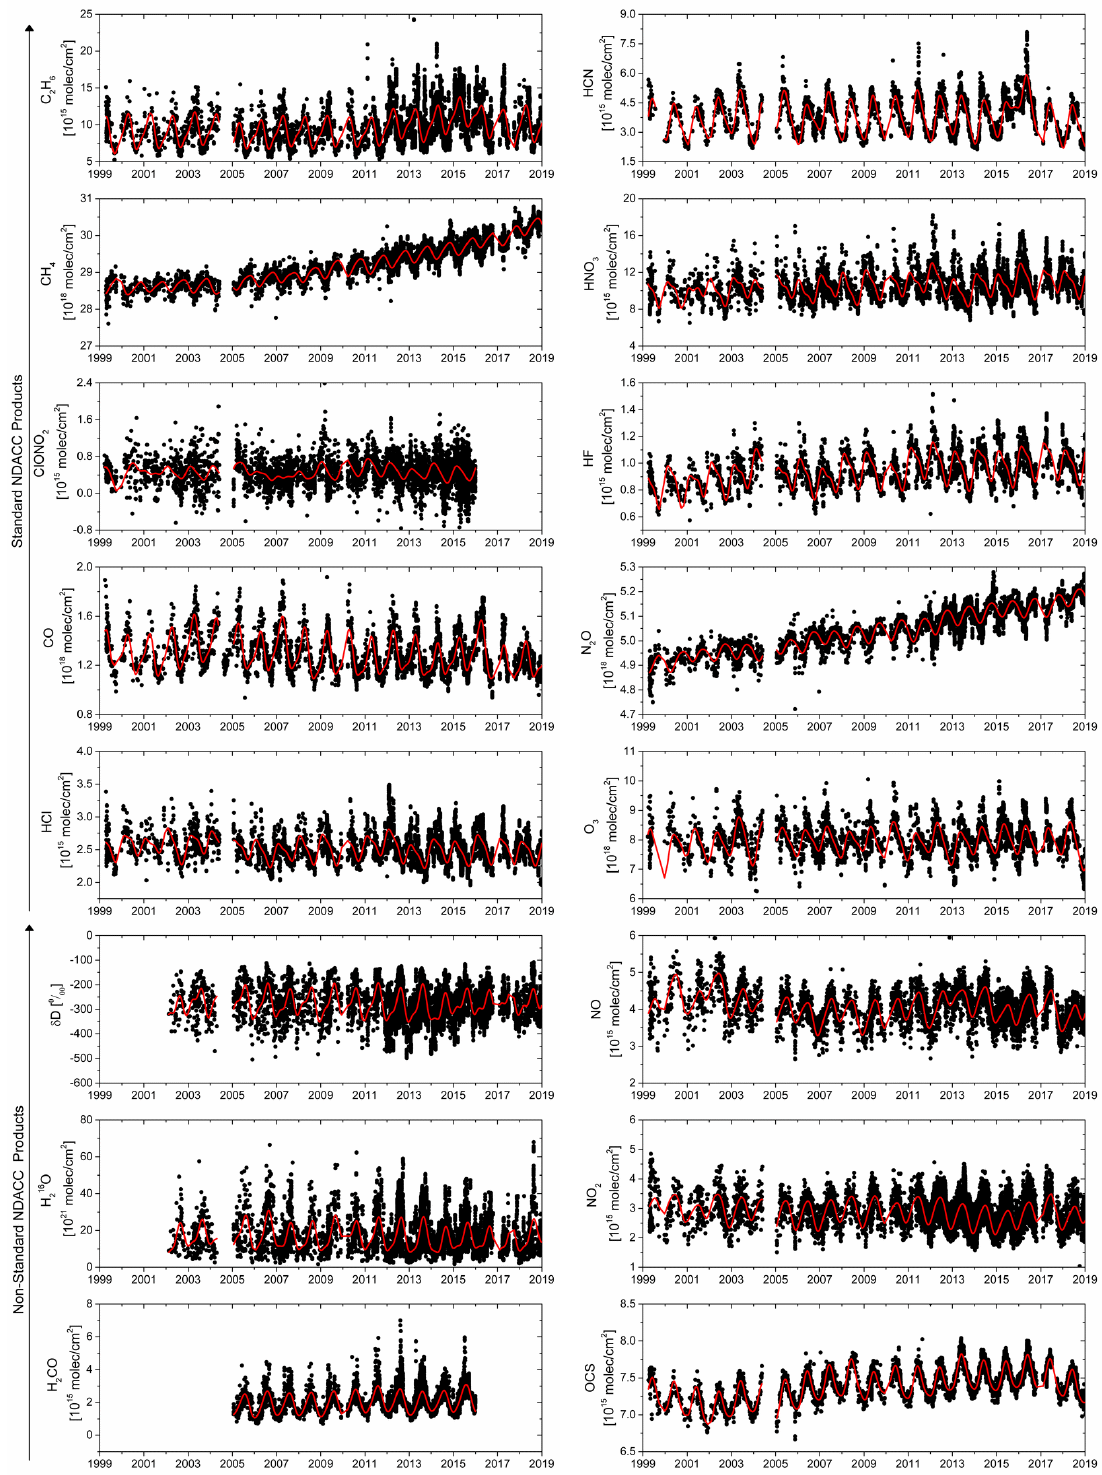
Figure 7. Time series of standard and non-standard NDACC TCs at IZO from 1999 to 2018. Black dots represent all FTIR measurements, while the multi-regression fit of the time series model (see Eq. B1) is depicted as red lines. Data gaps are due to instrumental issues (recall Table